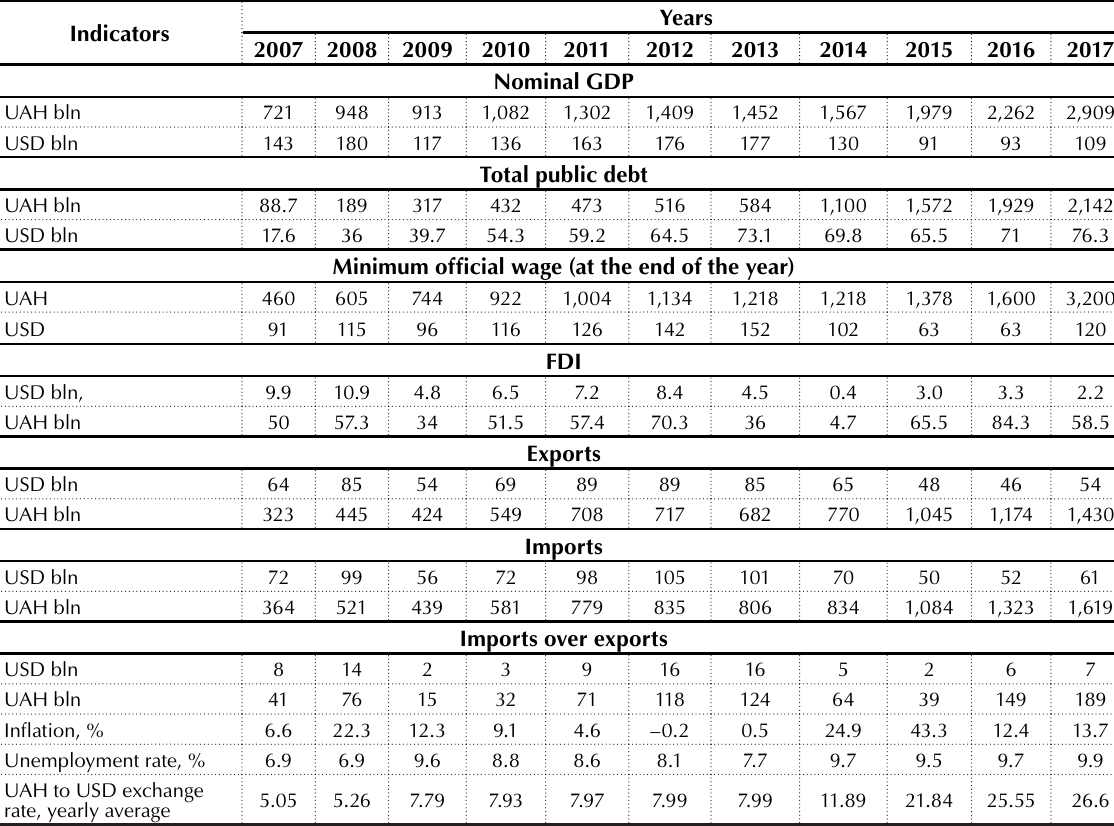
Source: State Statistics Service of